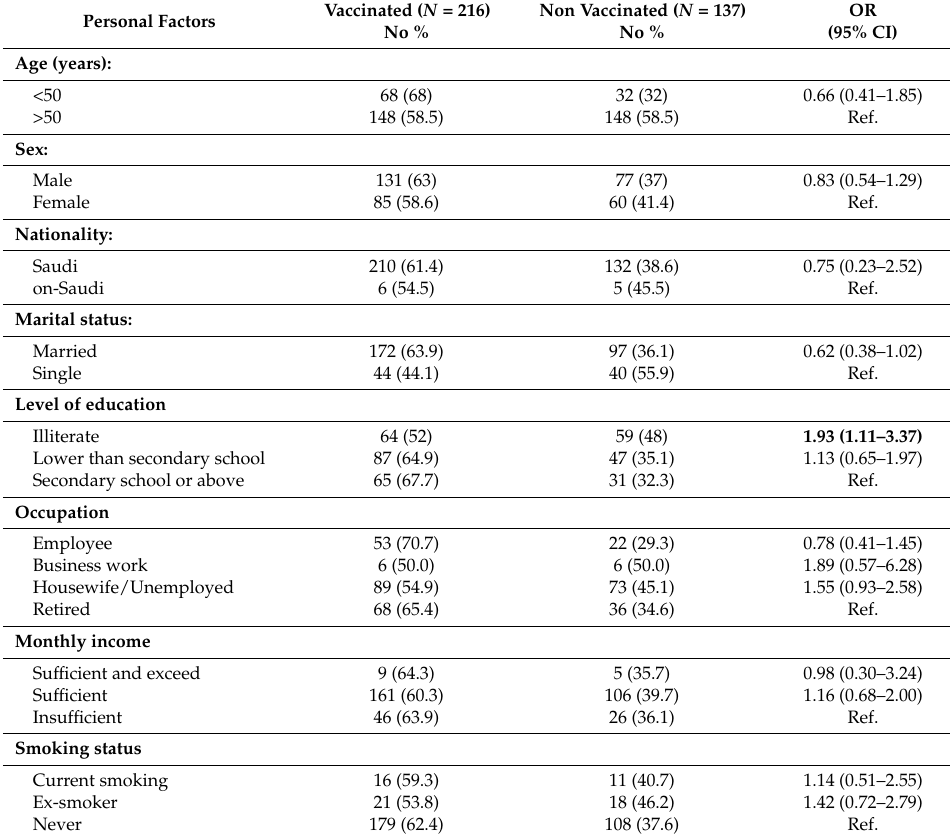
Table 3. Univariate analysis for personal factors associated with seasonal influenza non-vaccination in the study T2DM patients ( N =